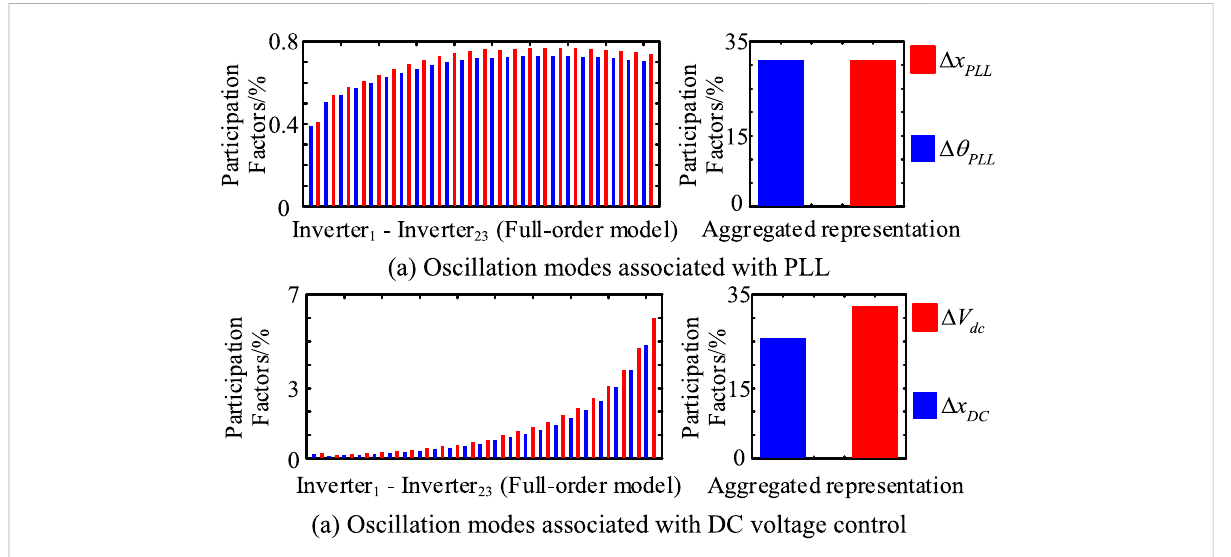
FIGURE 10 Computationalresultsofparticipationfactors(casestudy1,M=23). (A) OscillationmodesassociatedwithPLL. (A) Oscillationmodesassociated with DC voltage control.